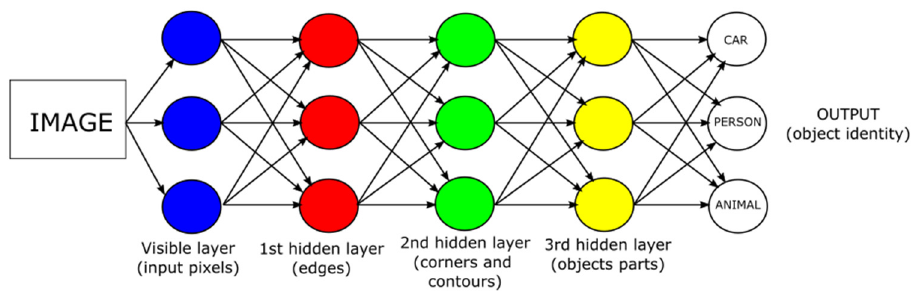
Figure 13. Basic principle of DL.